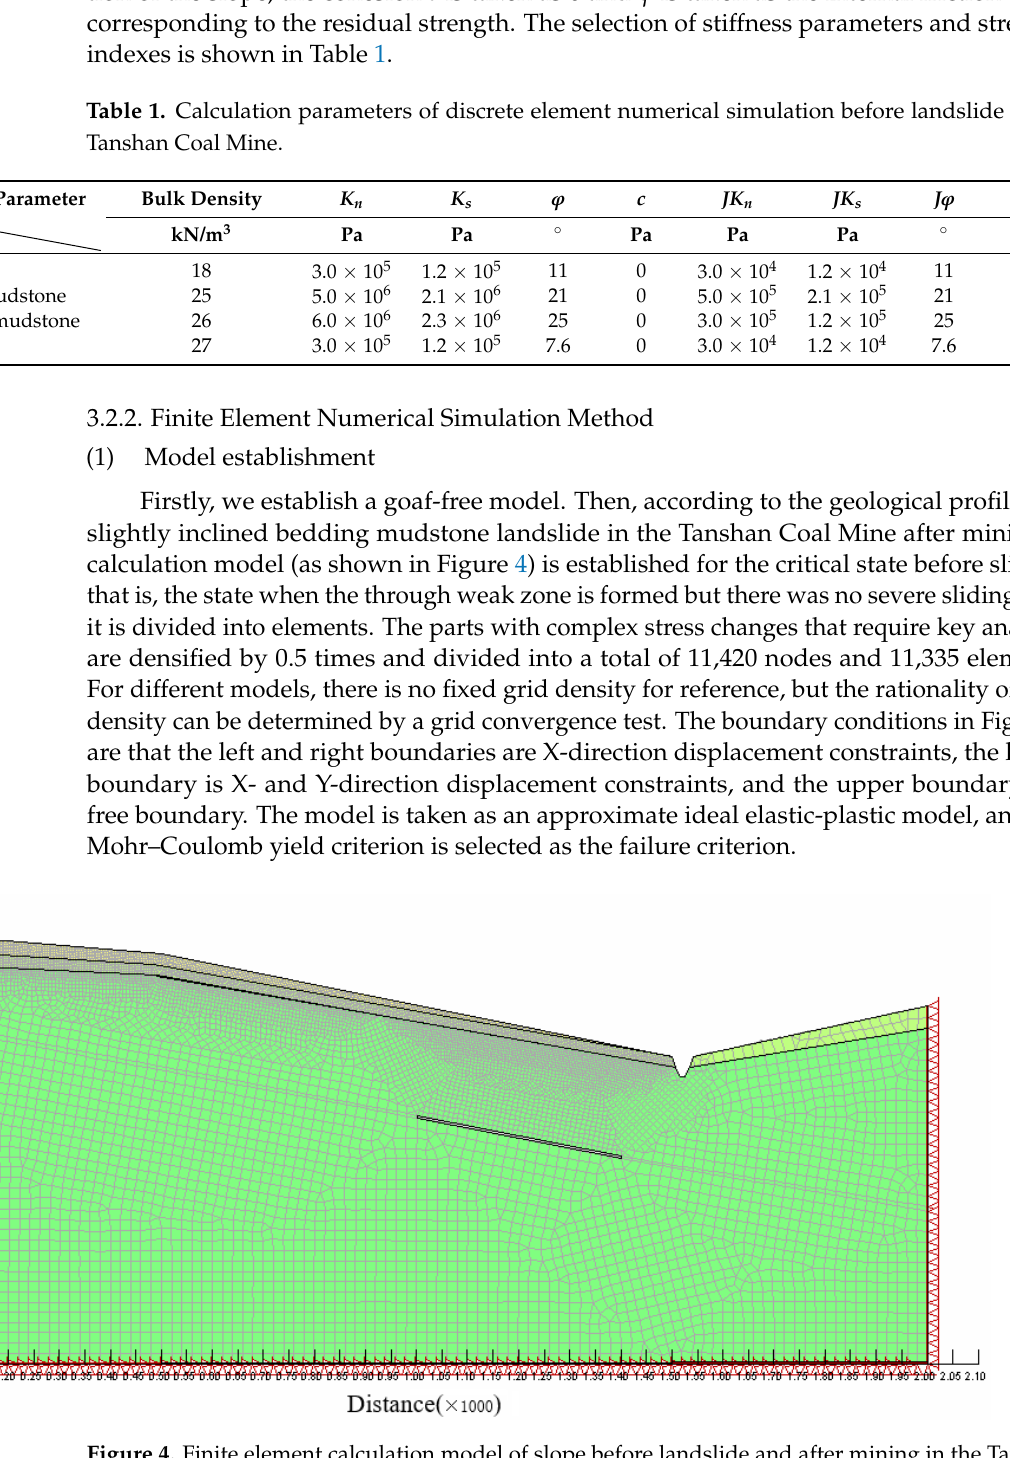
Table 2. Calculation parameters of finite element numerical simulation before landslide in the Tanshan Coal Mine. Rock and Soil Type